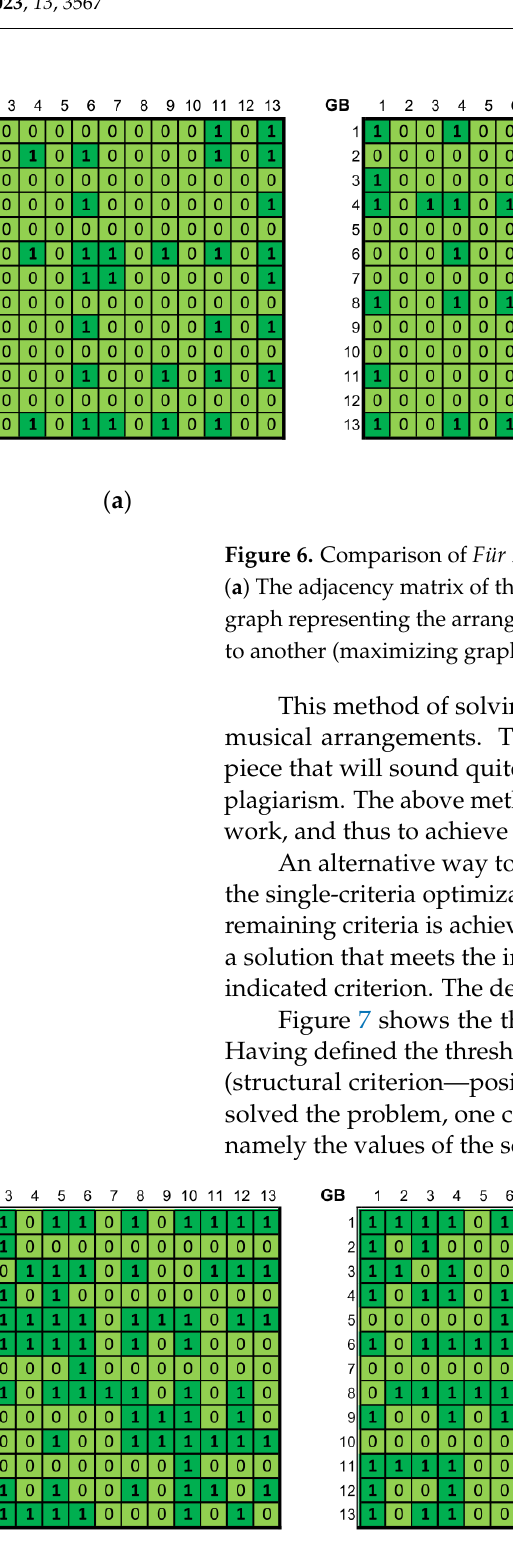
23 of 27 Figure 5. Comparison of Rolling in the Deep in the original and transposed versions. ( a ) The adjacency matrix of the graph representing the original piece. ( b ) The adjacency matrix of the graph represent- ing the transposed work. ( c ) The calculated optimal assignment matrix of vertices from one graph to another (maximizing graph similarity) together with the value of the objective function. In this way, in the case of the piece Rolling in the Deep , an attempt to deceive the anti- plagiarism system by transposing the piece to a different octave was simulated. As de- scribed in the Hamming and Levenshtein metrics (Section 3.1), plagiarism would not be detected if these “text” metrics were used. After transposition, the successive notes of the compared pieces differ in frequency (and thus also in note name), and this makes the cal- culated distance between them significant. The structural and quantitative method is resistant to the manipulation described above. Figure 5 shows that for the abovementioned comparison, the method calculated the optimal assignment resulting in a similarity value approximately equal to the maxi- mum possible value (0.334) for such parameters. Moreover, the optimal assignment itself also implies that we are dealing with plagia- rism. Visually, it can be seen that the values in the matrix in rows 3 – 12 form a “ribbon” under the diagonal, and the values in rows 1 – 2 (i.e., values “1” ) appear in cells (